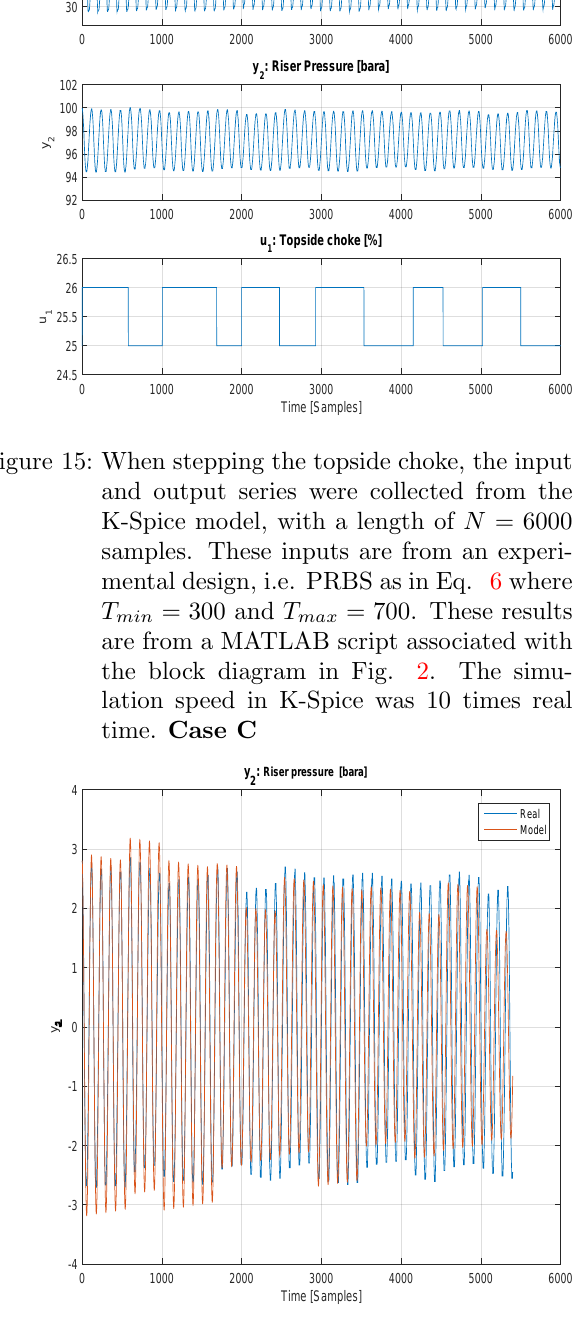
Figure 16: The model ( L = 5 , J = 5 , n = 4) is simu- lated and compared to the identification set, giving MSE = 0 . 5760. Case C